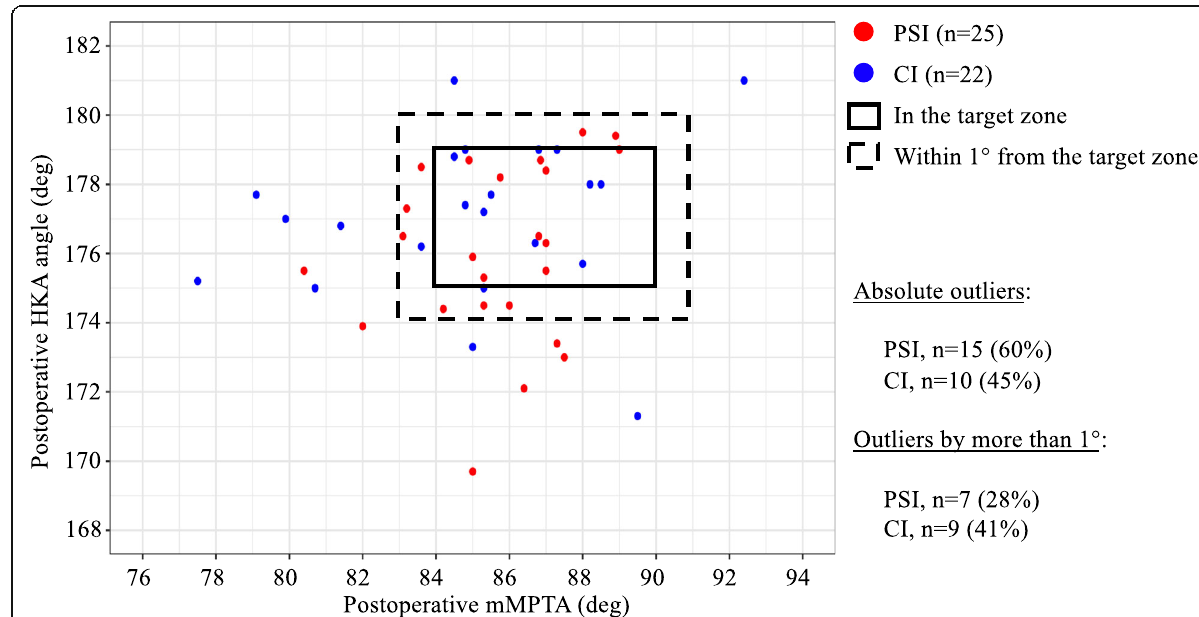
Fig. 3 Comparison of UKA using PSI versus conventional instrumentation for tibial component alignment to achieve the coronal alignment target